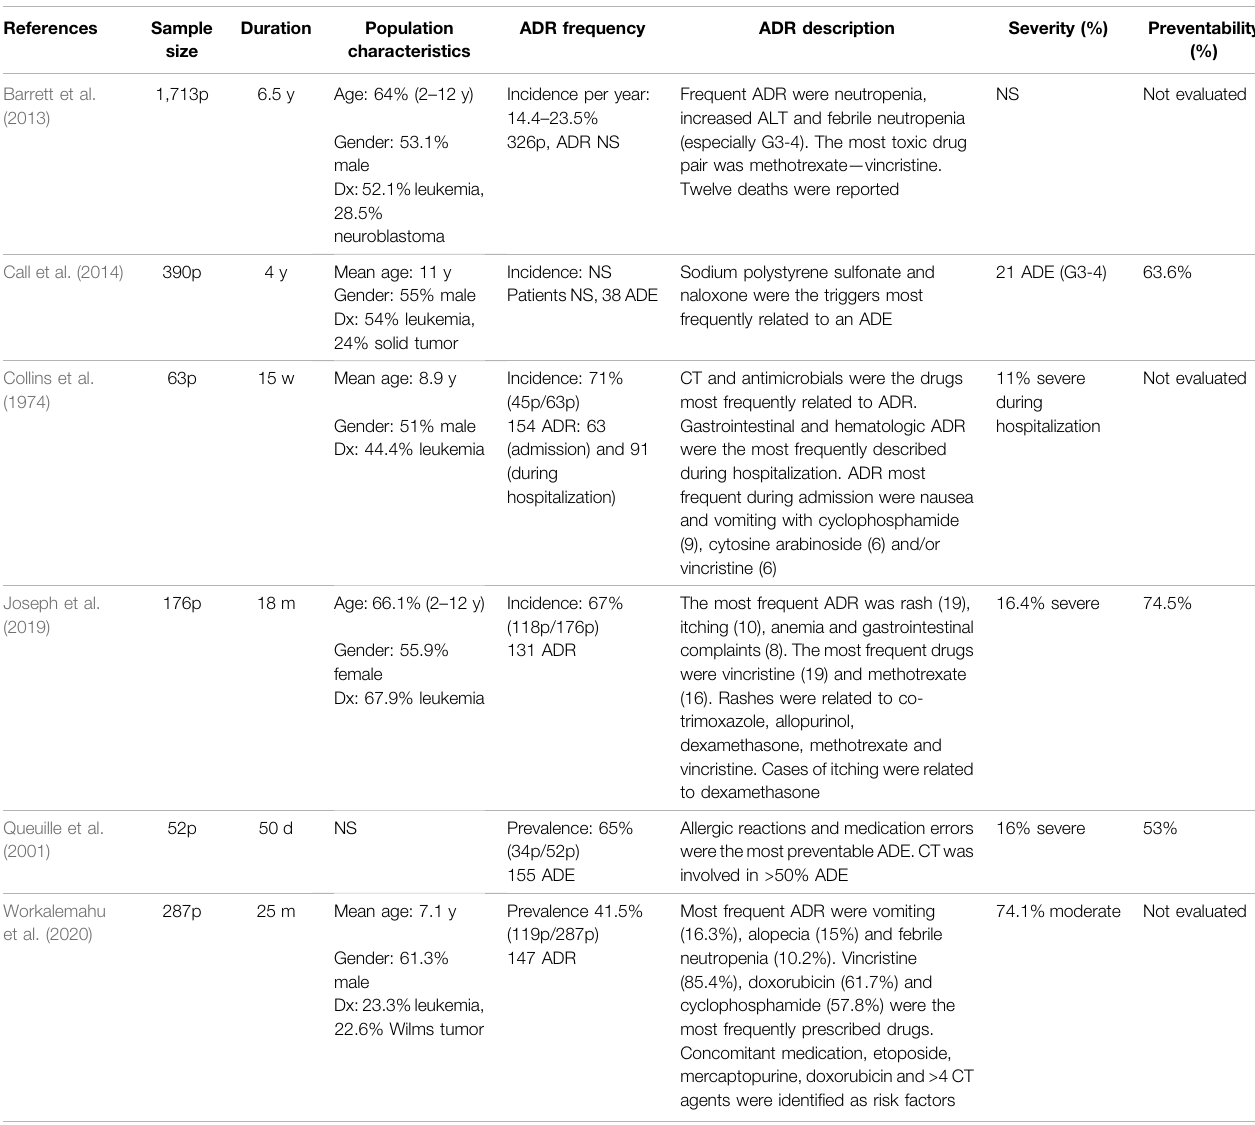
TABLE 3 | Clinical results in pediatric oncohematology